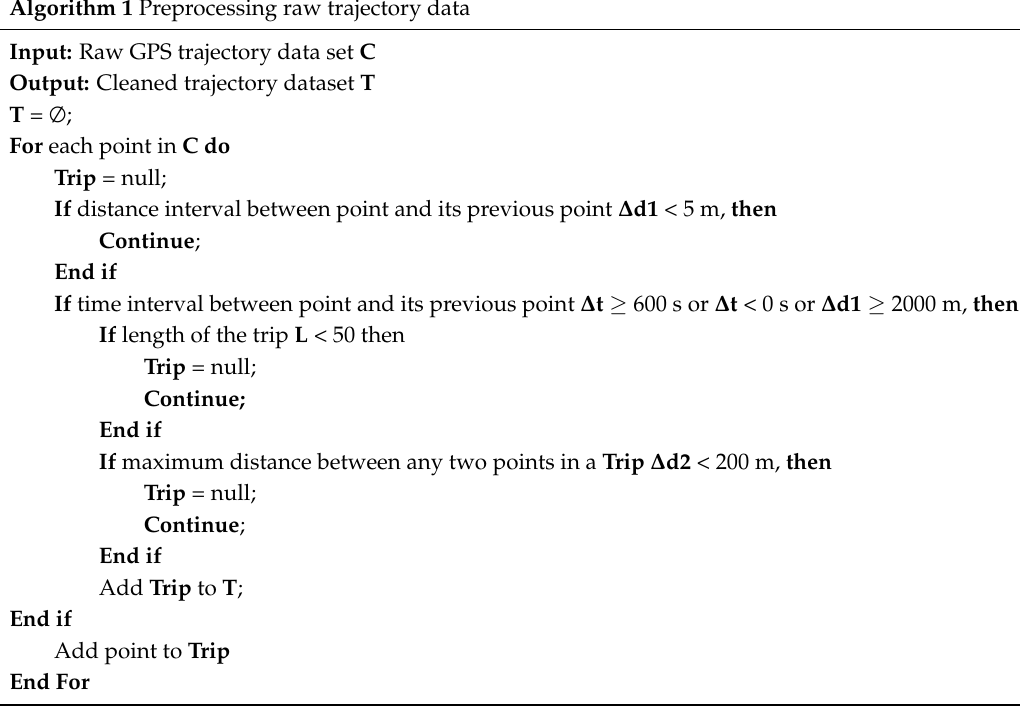
Algorithm 1 Preprocessing raw trajectory